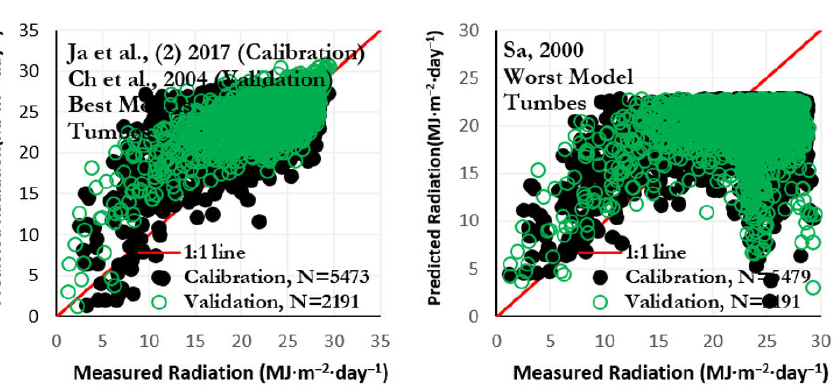
Figure 2. Measured solar radiation versus values estimated by best and poorest empirical models in calibration and validation sets at all stations.